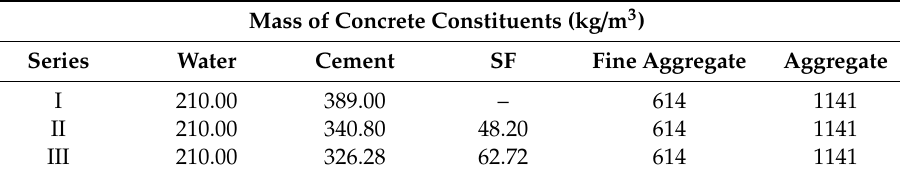
Table 1. The proportion of concrete constituents with di ff erent SF levels by weight [67].